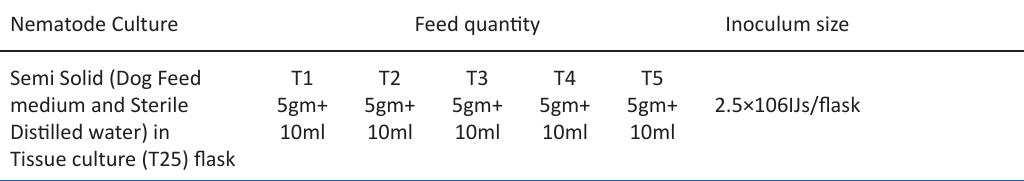
Table 3. The nematodes were harvested on the 20 th day from the date of inoculation from all the flasks Nematode